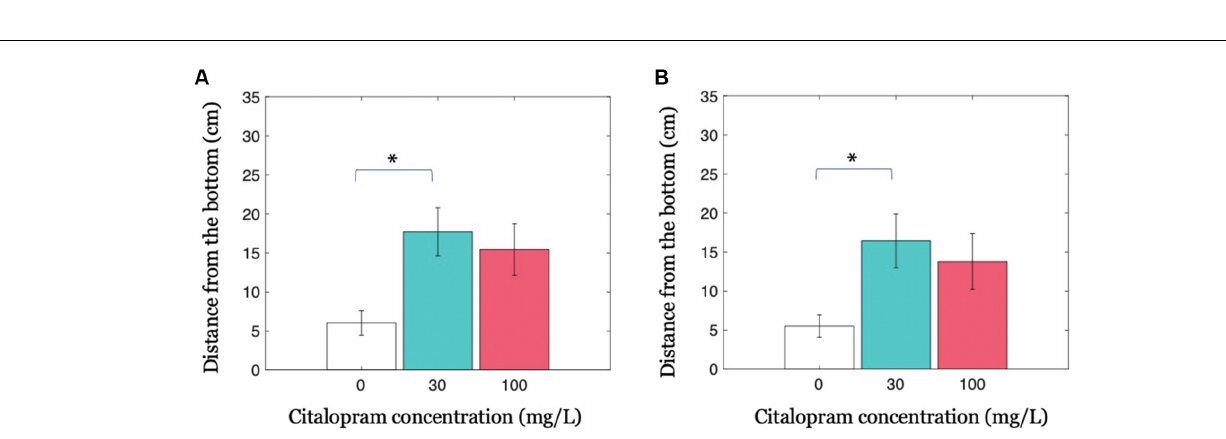
FIGURE 3 | Group geotaxis as a function of Citalopram administration. (A) Distance from the bottom of the tank for condition Groups. (B) Distance from the bottom of the tank for the untreated members in condition Groups. ∗ p < 0.050 compared to vehicle-treated